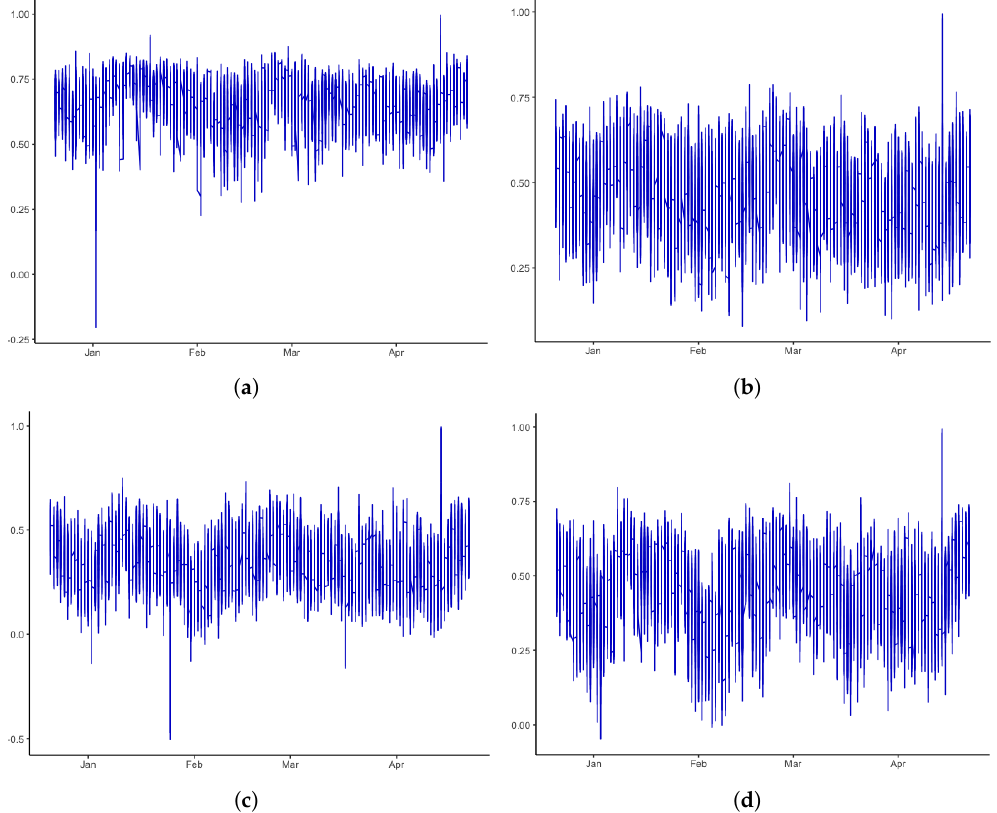
Figure 4. Conditional correlation between the cryptocurrencies. ( a ) Conditional correlation between BTC and ETH; ( b ) conditional correlation between ETH and LTC; ( c ) conditional correlation between LTC and XRP; ( d ) conditional correlation between BTC and